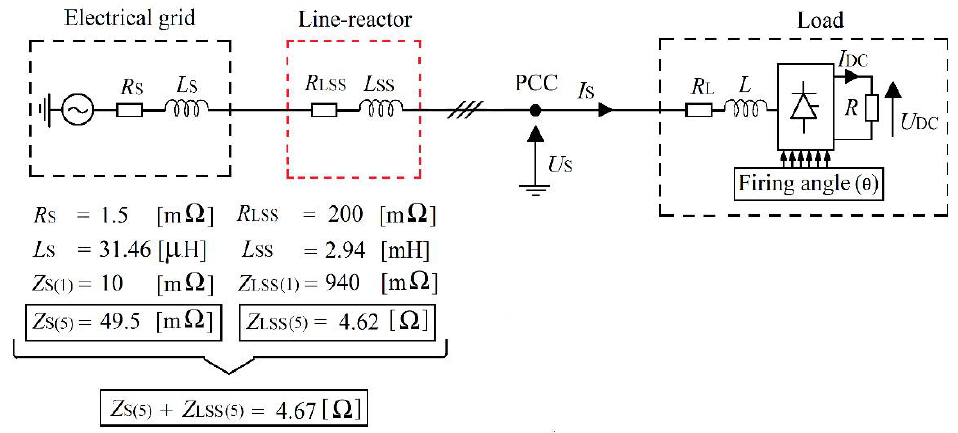
Figure 39. Equivalent circuit of laboratory model with line reactor. Table 7. Parameters of the fundamental harmonic active and reactive powers as well as DPF for different rectifier firing angles measured at the PCC.